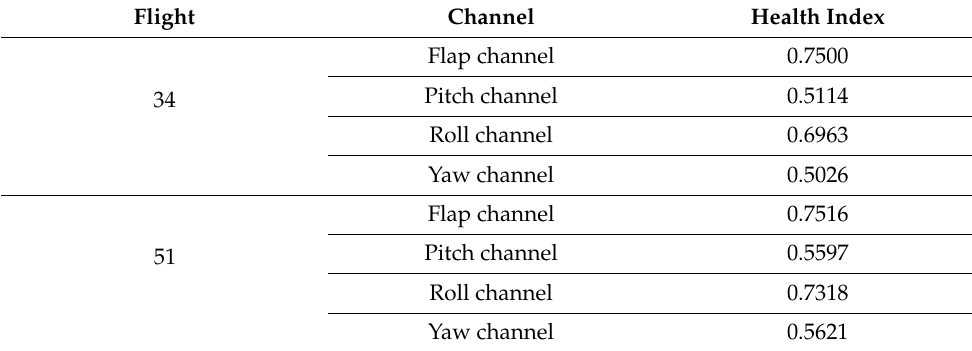
Table 6. Health index of each channel of flight 34 and flight 51.